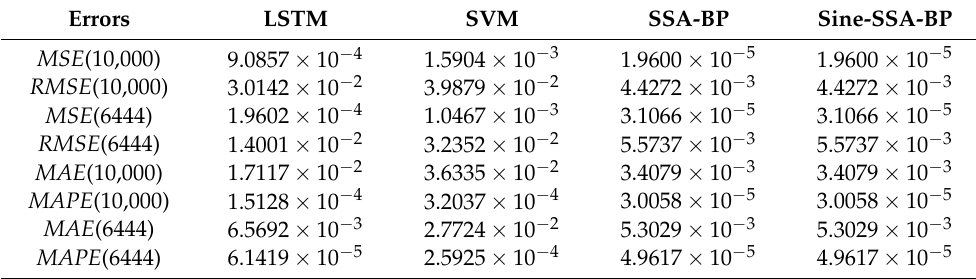
Table 5. Model generalization